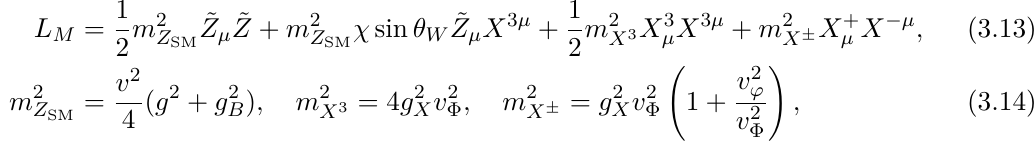
Figure 1 . sin θ ZZ 0 as a function of m